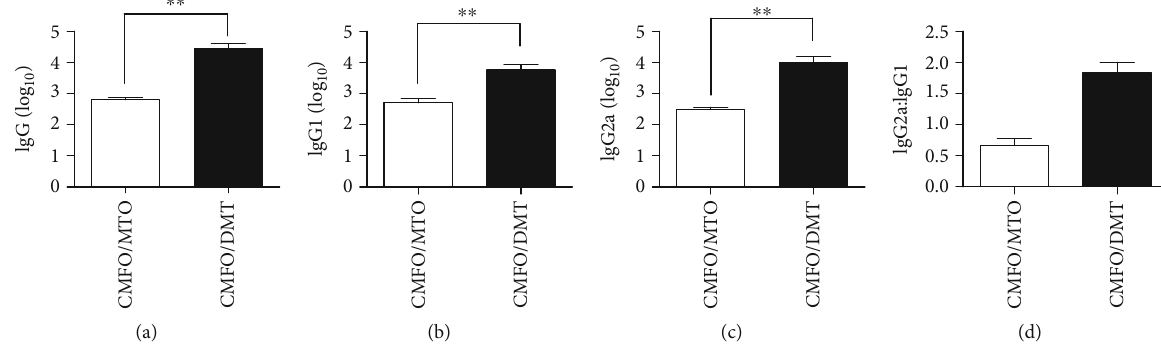
Figure 1: CMFO-speci fi c antibody responses in di ff erent immunized mice ( n = 6 ). Mice were vaccinated with PBS, MTO, DMT, CMFO/MTO, and CMFO/DMT. 10 weeks later, CMFO-speci fi c antibodies IgG (a), IgG1 (b), and IgG2a (c) in the serum of each mouse were tittered by ELISA. The results were shown as the mean ( ± SEM) log groups of vaccinated mice. ∗∗ p < 0 : 001 Student t -test and ANOVA test (one-way or two-way) were